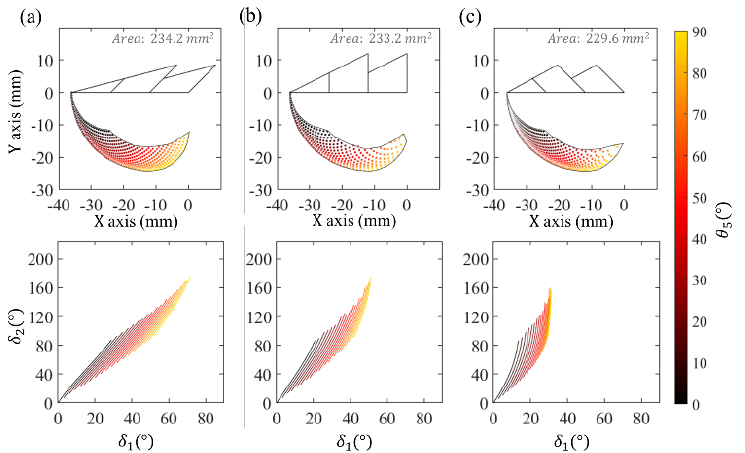
Figure 12. Scatter plots ( top ) and input – output angle relationships ( bottom ) of the double four-bar linkage structures when h 1 = 1.0 L with different initial angle values: ( a ) ϕ & ψ = 45 ◦ , ( b ) ϕ & ψ = 90 ◦ , and ( c ) ϕ & ψ = 135 ◦ .